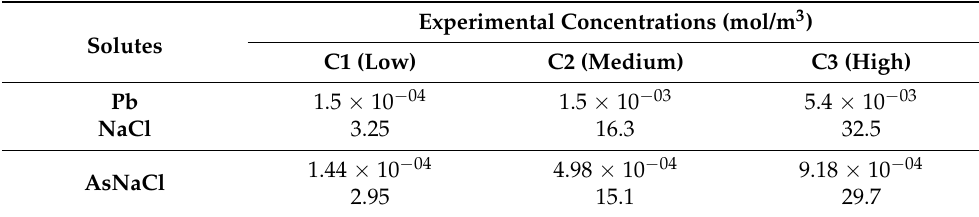
Table 2. Concentrations of solutes in synthetic water.